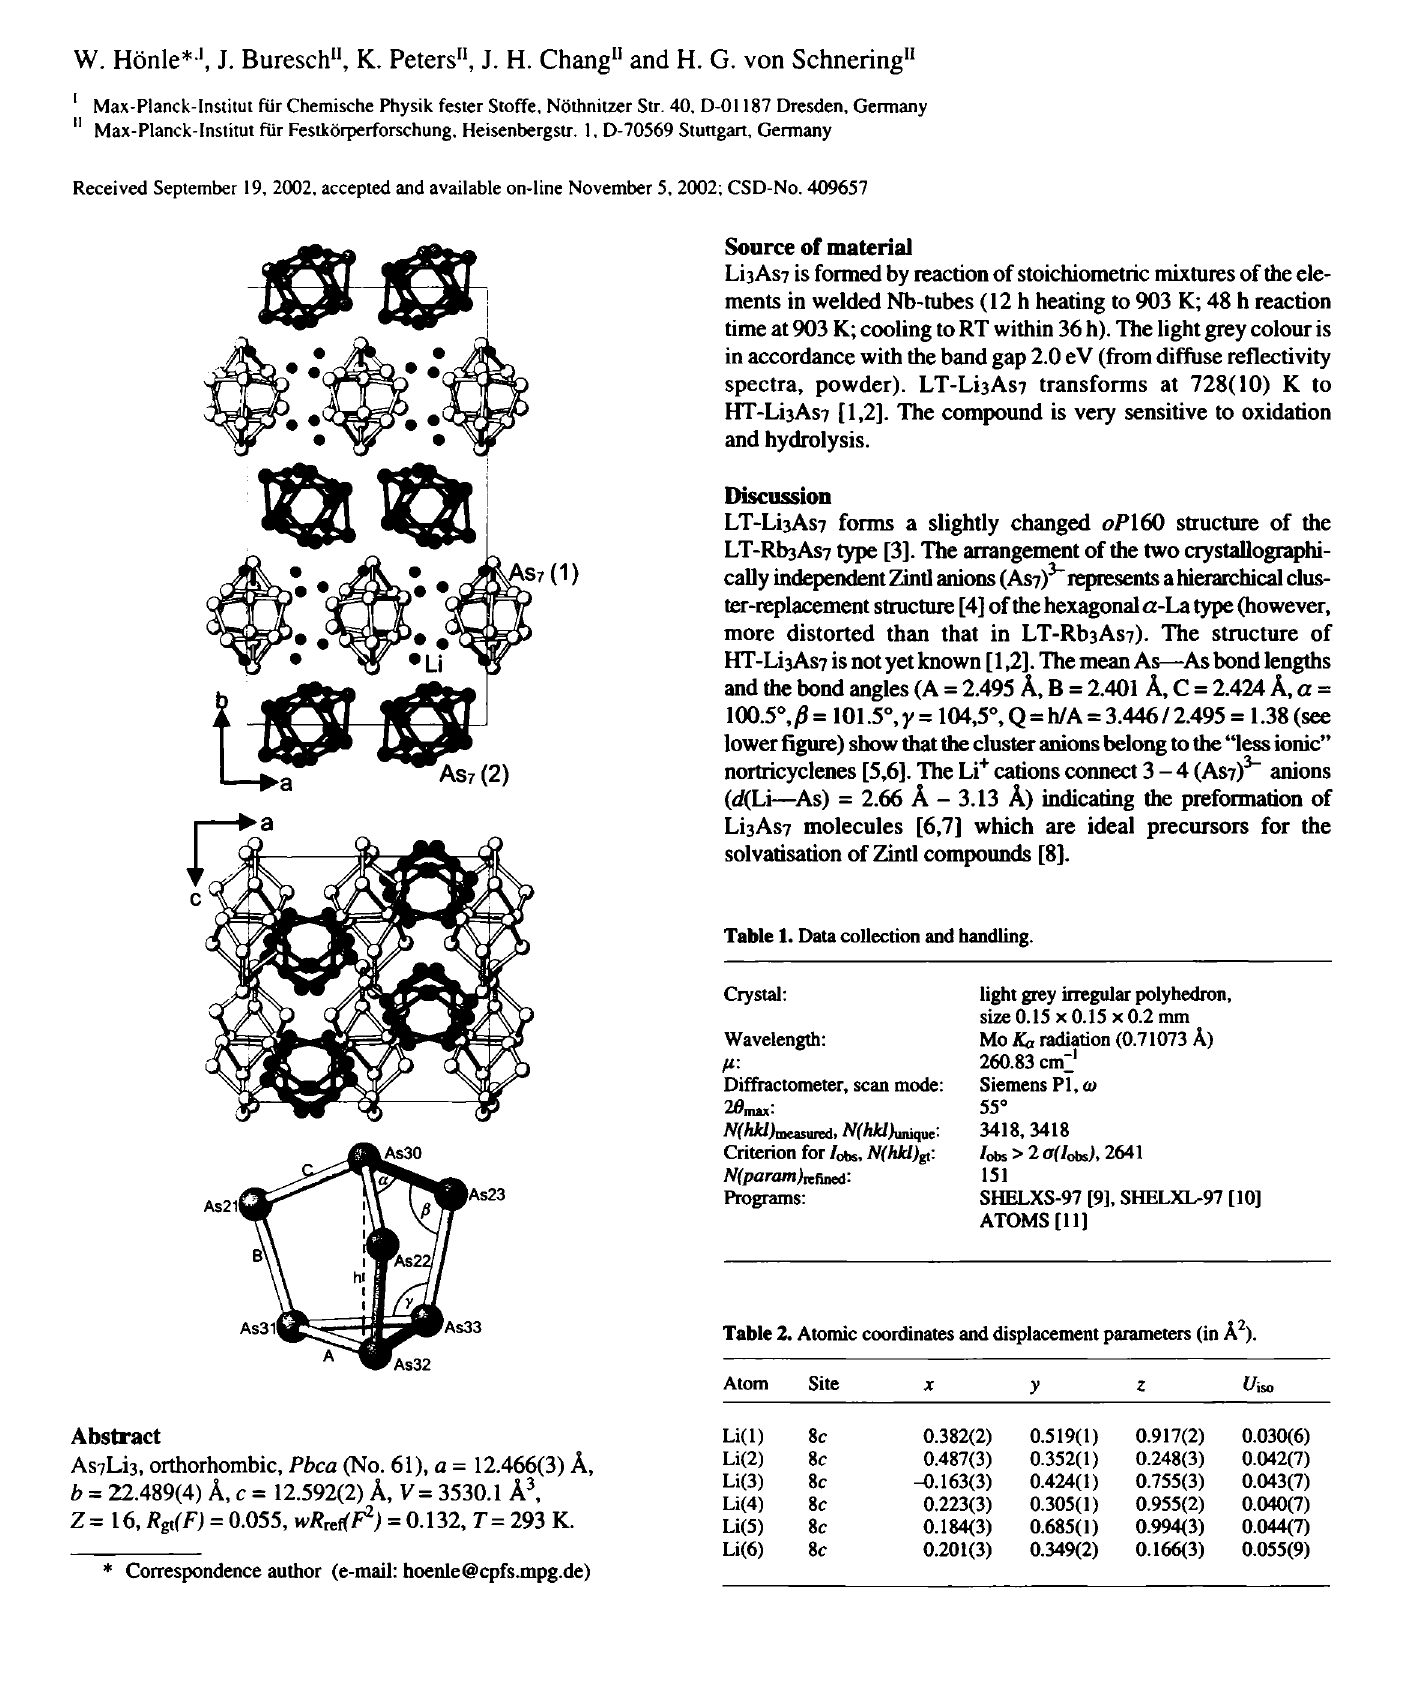
Table 2. Atomic coordinates and displacement parameters (in Â 2